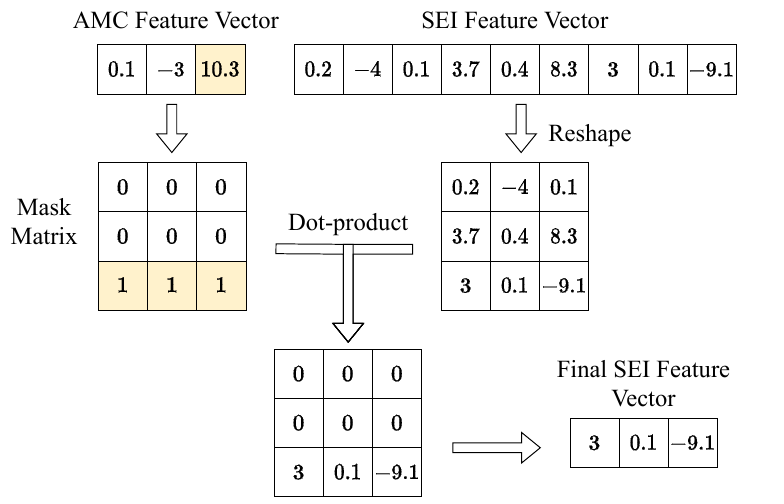
Figure 7. The calculation process of the SEI feature vectors. The mask matrix is generated from the AMC feature vector. The subscript of the largest element of the AMC feature vector determines which row of the mask matrix is 1. The colored part of this figure indicates the maximum value in the vector and the row of the matrix that takes